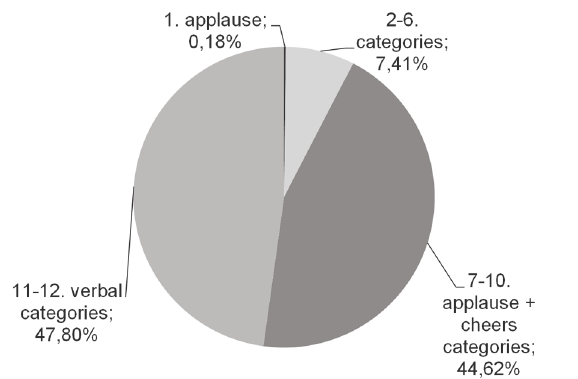
Figure 2. Collective audience responses in campaign